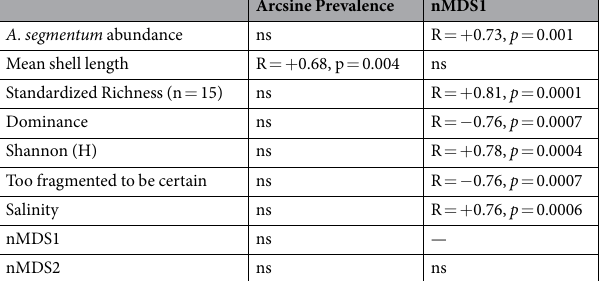
Table 1. Spearman rank correlation coefficients and p -values (when p < α = 0.05; otherwise indicated as ns: non-significant) between arcsine-transformed trematode prevalence values of Abra segmentum from the 204- S7 core; nMDS1 sample scores; and environmental, ecological, and taphonomic variables. nMDS1: Non metric Multidimensional Scaling axis 1.